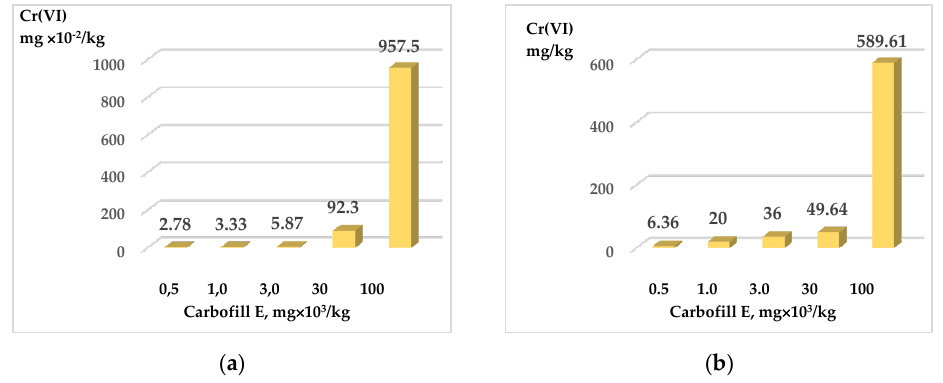
Figure 8. Washing out of chromium compounds from SCS sandy samples with immobilized various amounts of Cr (VI) and 10% Carbofill E. Samples: uncrushed—( a ); crushed—( b